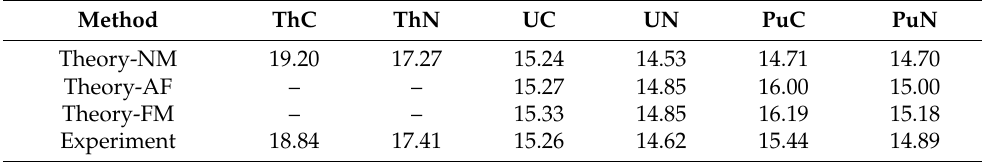
Table 1. The atomic volumes in Å 3 /atom from present theory and experimental data [16,31–35]. Method